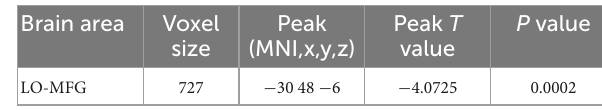
TABLE 1 Demographic characteristics of the LDH patients and HC groups.